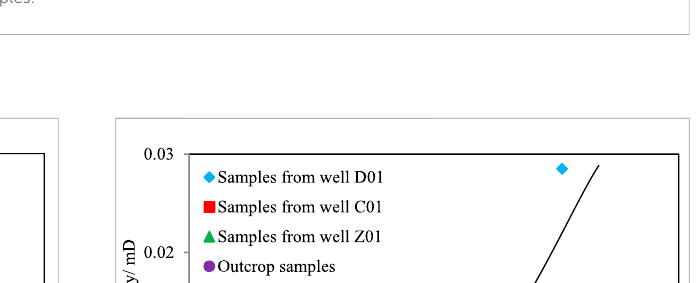
FIGURE 7 Mineral compositions for the core samples and outcrop samples.